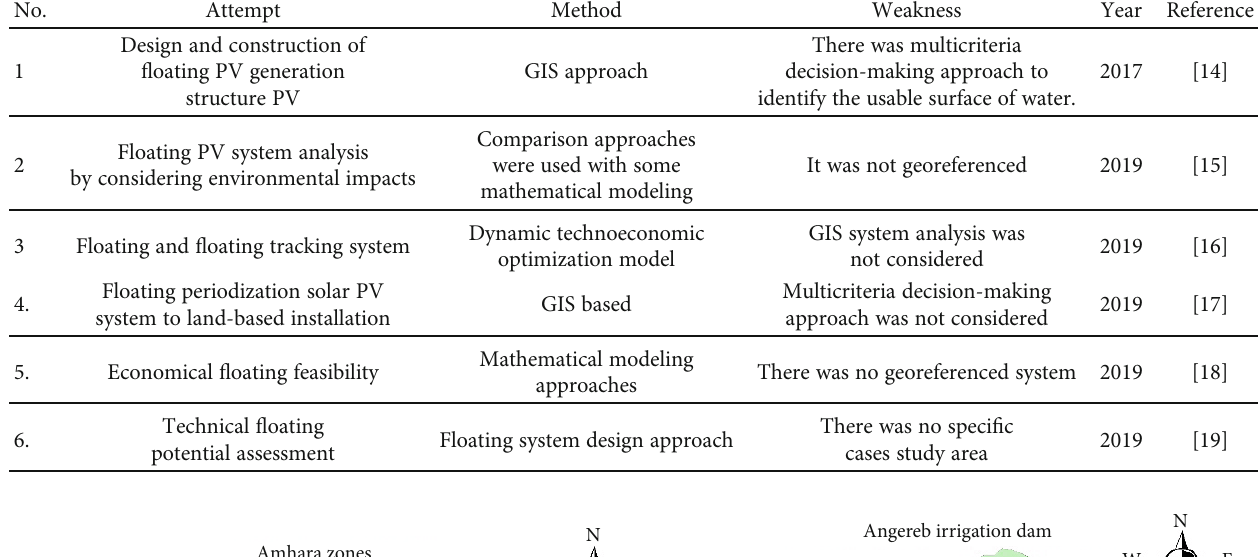
Table 1: Solar PV fl oating system related studies without multicriteria decision-making perspectives.